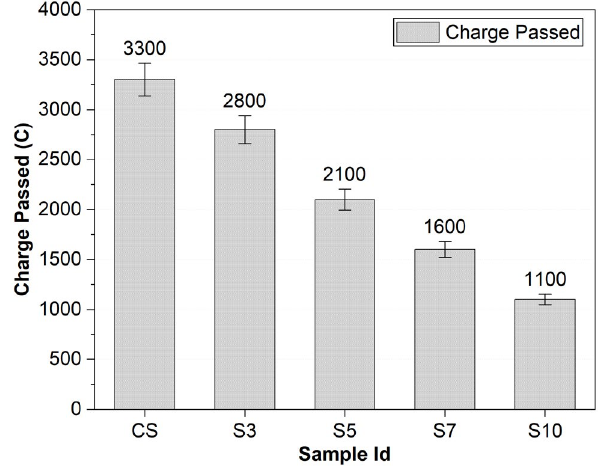
Figure 6. Average Charge Comparison of RCPT Specimens (ASTM C1202).